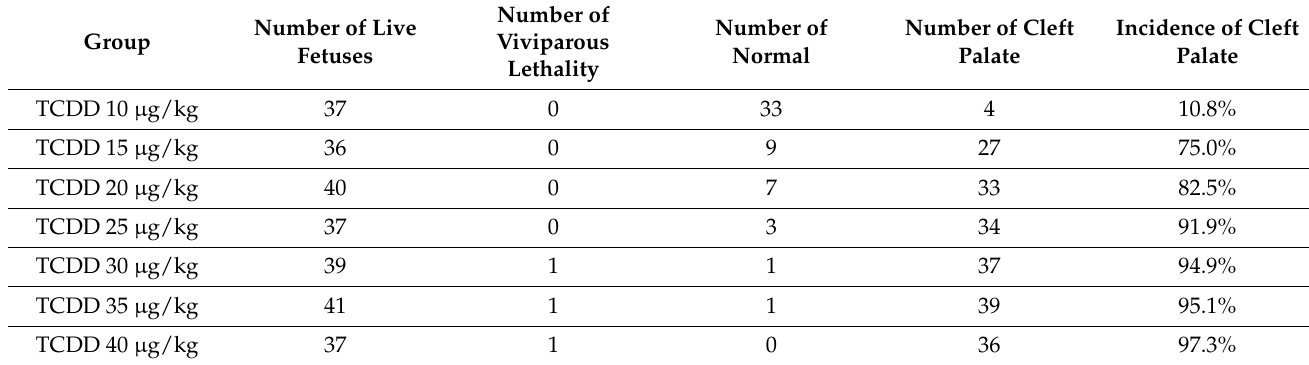
Table 2. Incidence of cleft palate in each